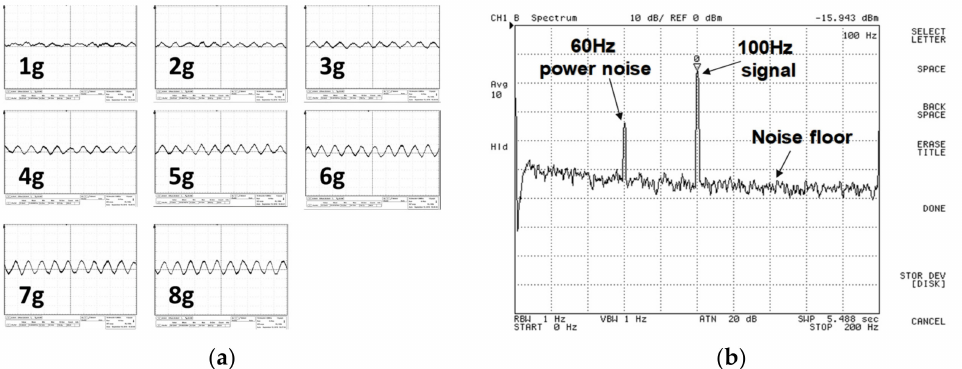
Figure 28. ( a ) Measurement waveform of the accelerometer along the X -axis (scale: 6 mV/div); ( b ) measurement spectrum of 4 g acceleration along the Z -axis (scale: 10